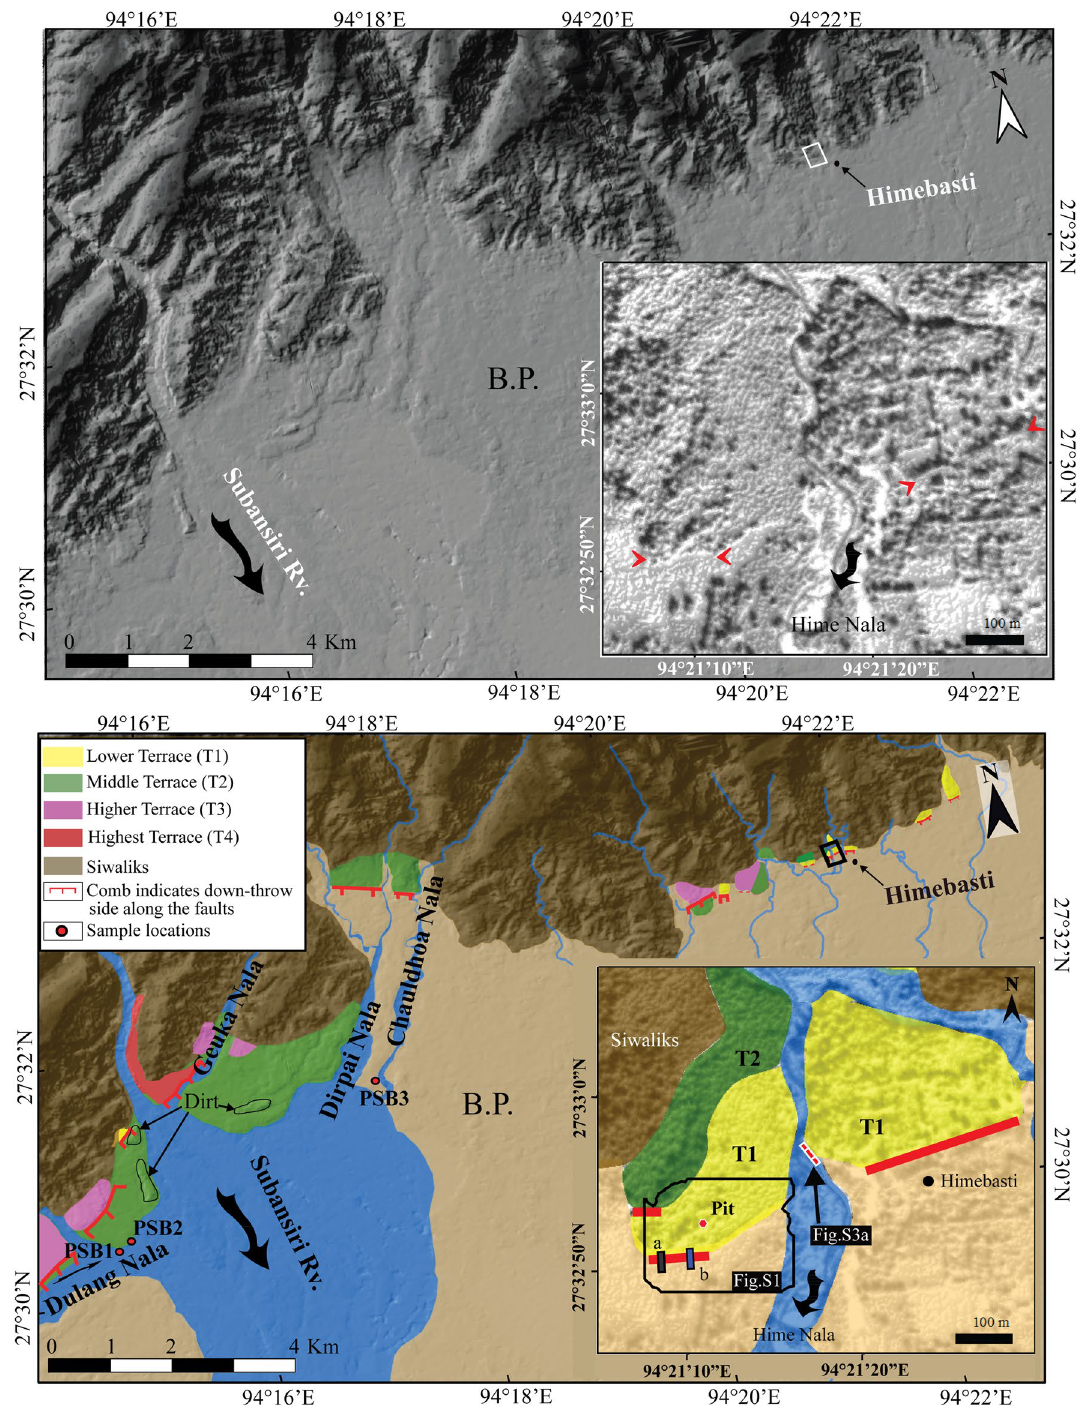
Figure 2. Cartosat-1A digital elevation model showing the regional tectonic-geomorphic map of the trench site at Himebasti. (Top) Un-interpreted Cartosat-1A digital elevation model showing the extent of different terraces. (Inset) the small red arrows in the inset are pointing at the strike of the scarp. (Bottom) mapped terraces are differentiated by different colours in and around the study area. (Inset) Detailed tectonic-geomorphic map of the trenched site at Himebasti village. A small black outlined polygon box depicts the location of Figure S1. Letters ’a’ and ’b’ denotes the locations of the previous 20 and present trench sites, respectively. BP—Brahmaputra Plain. Maps were prepared using Cartosat-1A imageries purchased from http://www.nrsc.gov.in (Source: NRSC, ISRO/ DOS) and processed in SOCET GXP version 4.1.0 software and artwork in Adobe Illustrator CS5